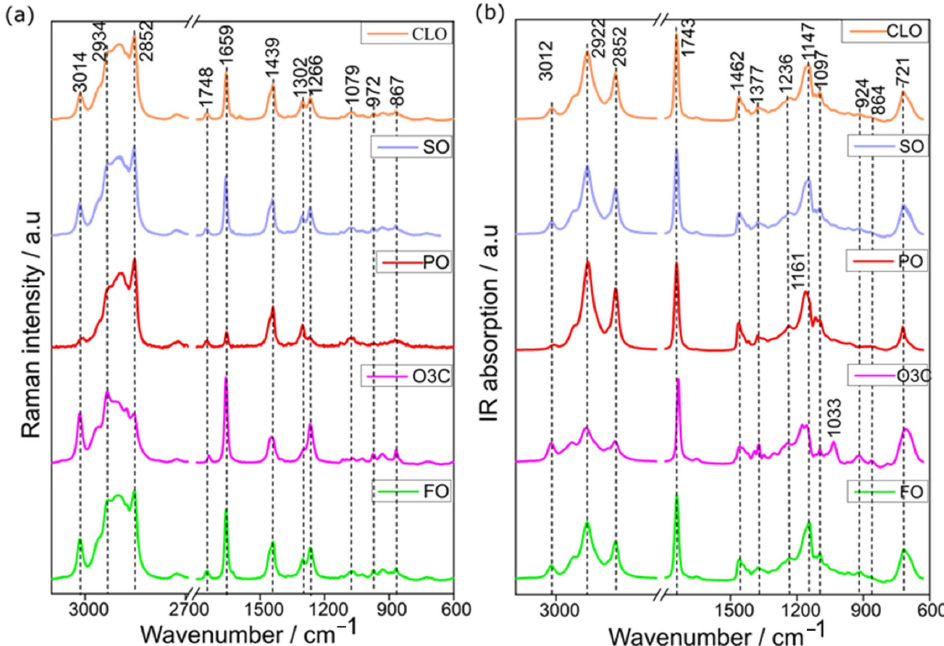
Figure 1. The mean (± Std.Dev) spectra of CLO (n = 6 samples), SO (n = 6 samples), and the three adulterants studied (palm oil, omega ‐ 3 concentrates in ethyl ester, and fish oil) collected using ( a ) Raman and ( b ) IR instruments.